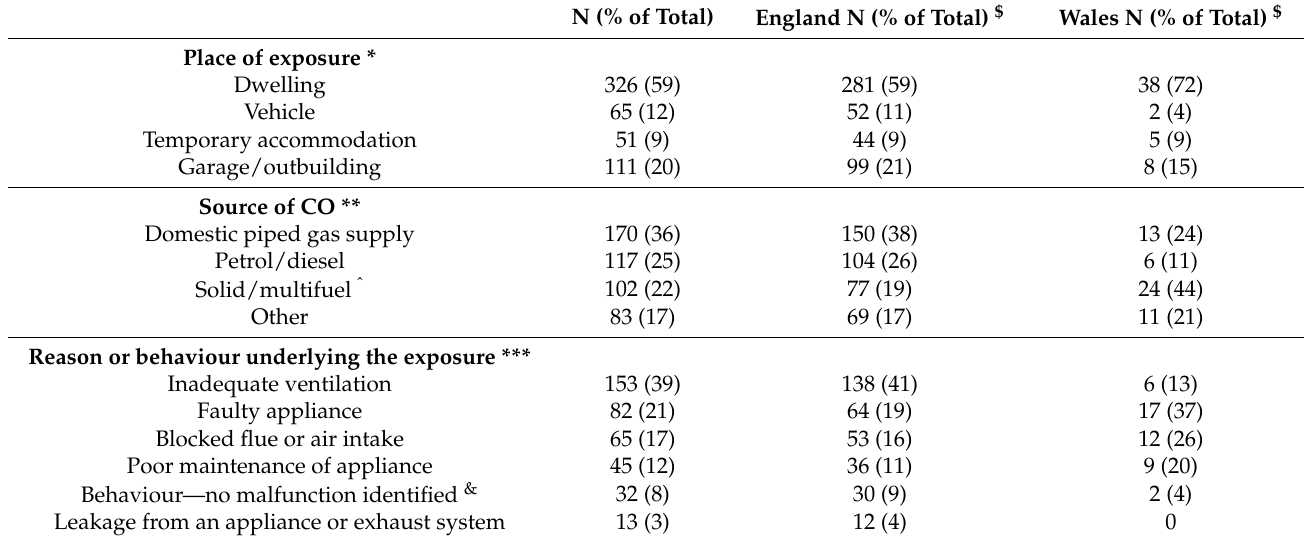
Table 3. The place, source, and underlying reason or behaviour for exposure of fatal UNFR CO poisoning in England and Wales, 1998–2019 (N =